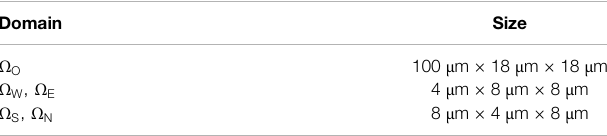
TABLE 3 | Speci fi cation of the size of the subdomains of a single cell used in the simulations of connected cells (see Figure 8 ). Domain